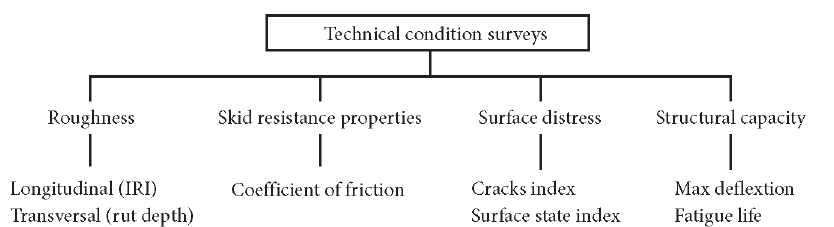
Fig. 1. Sample diagram of properties that are usually considered to assess the technical condition of pavement in PMS